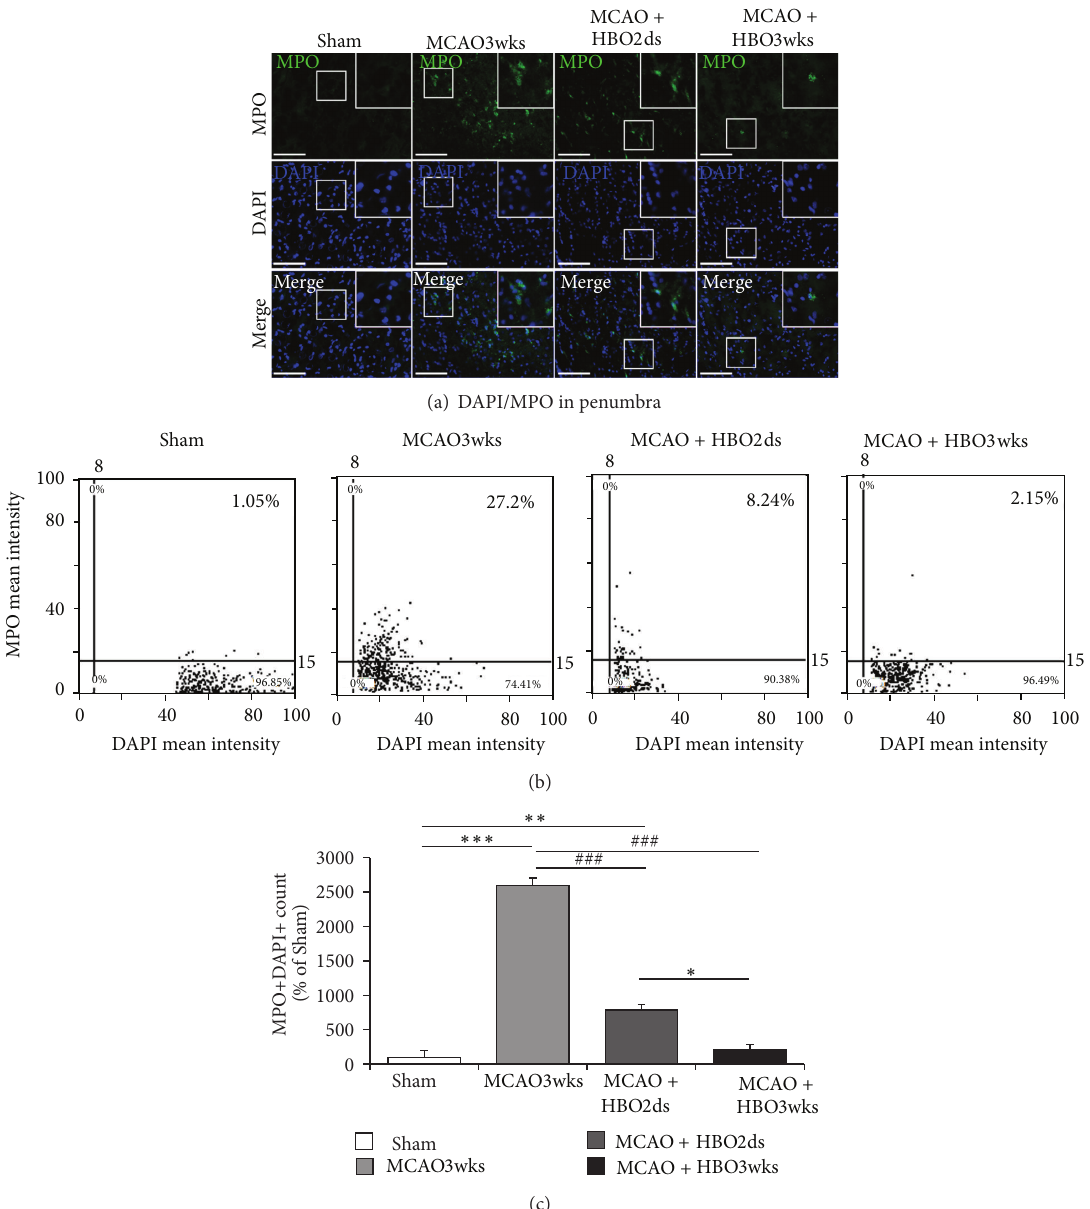
Figure 6: Long course HBO reduced inflammation. (a) MPO staining in penumbra striatum showed there was lower MPO expression in HBO2ds and HBO3wks group. (b) Representative images of tissue cytometry using TissueQuest software. MPO positive cells and DAPI positive cells were counted and the signal intensities were quantified. (c) The amount of double positive cells with MPO and DAPI in the ischemic boundary was recorded as the percentage of MPO positive cells in all cells. The difference was significant, as compared with HBO2ds group and HBO3wks group ( ∗ 𝑃 < 0.05 ). The difference was more significant, as compared with MCAO3wks group and HBO3wks group ( ∗∗∗ 𝑃 < 0.001